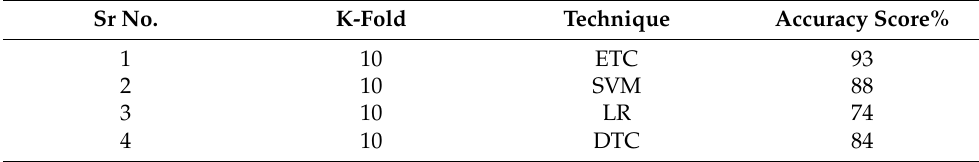
Table 5. The K-Fold cross-validation comparative analysis among the employed approaches. Sr No.